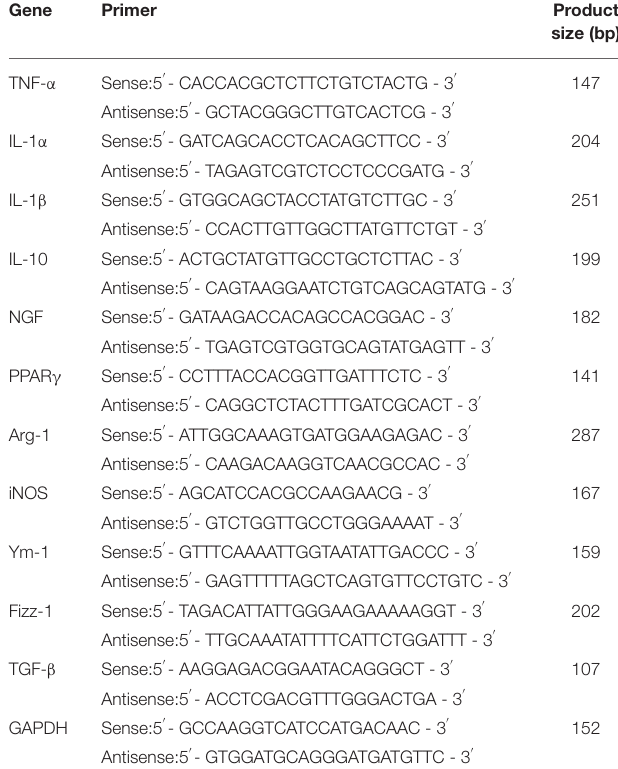
TABLE 1 | PCR primers used in this